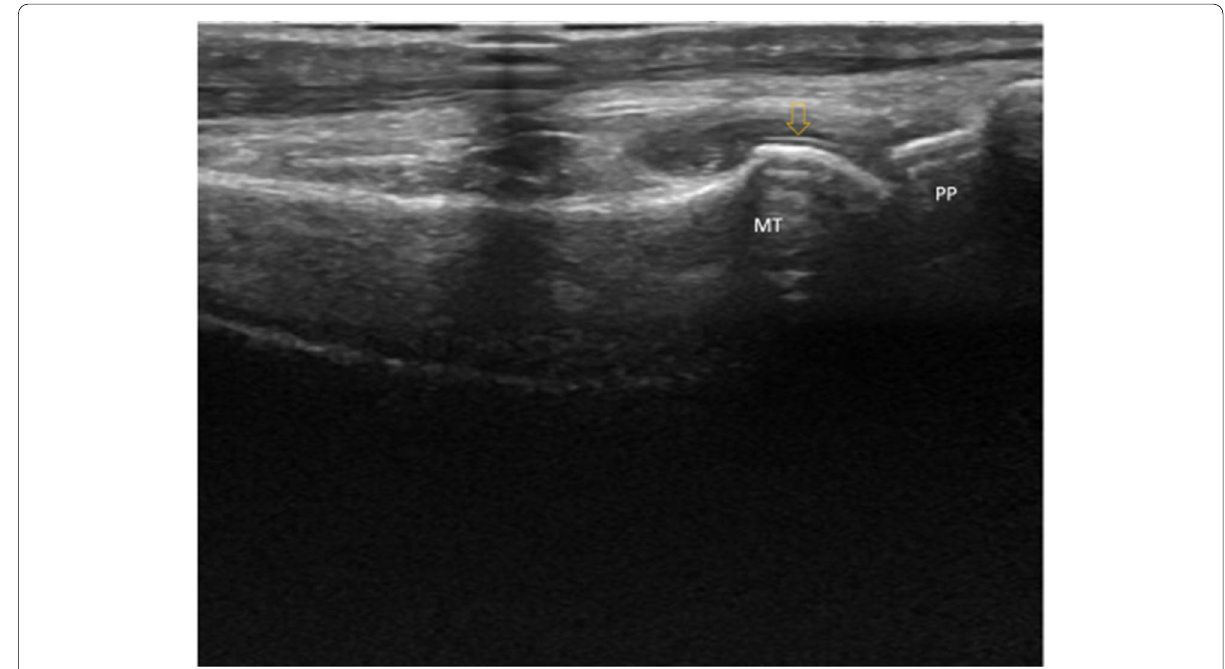
Fig. 2 Dorsal longitudinal gray scale ultrasound scan of the 1st MTP joint showing double contour (arrow)